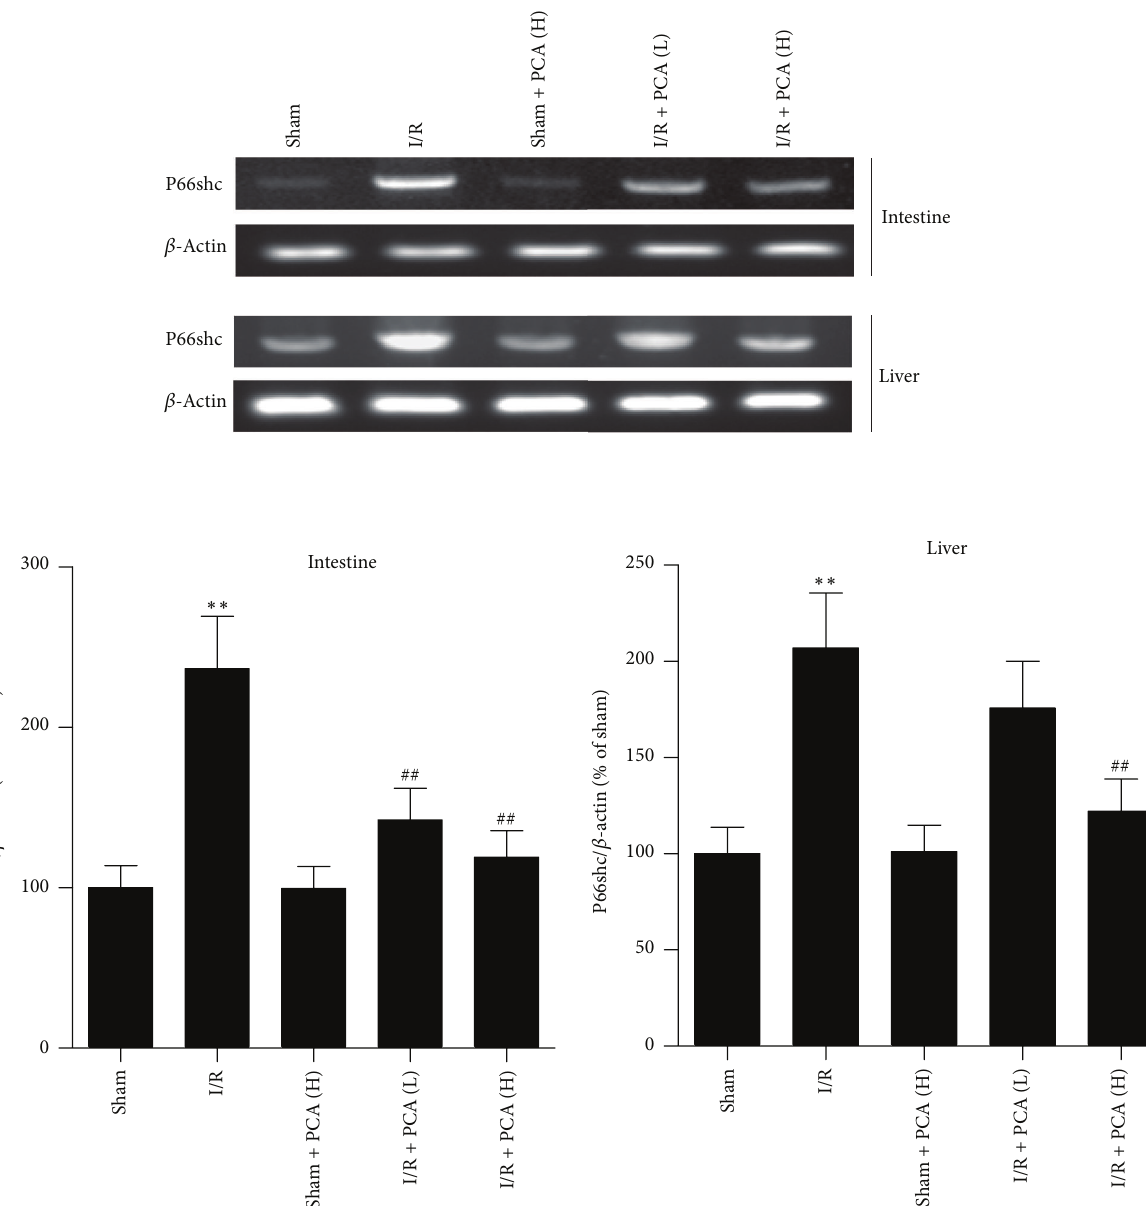
Figure 4: PCA pretreatment suppressed the mRNA expression of p66shc in the intestine and liver after intestinal I/R. Results are presented as the mean ± SD, 𝑛 = 3 . ∗∗ 𝑃 < 0.01 versus sham group; ## 𝑃 < 0.01 versus I/R group.